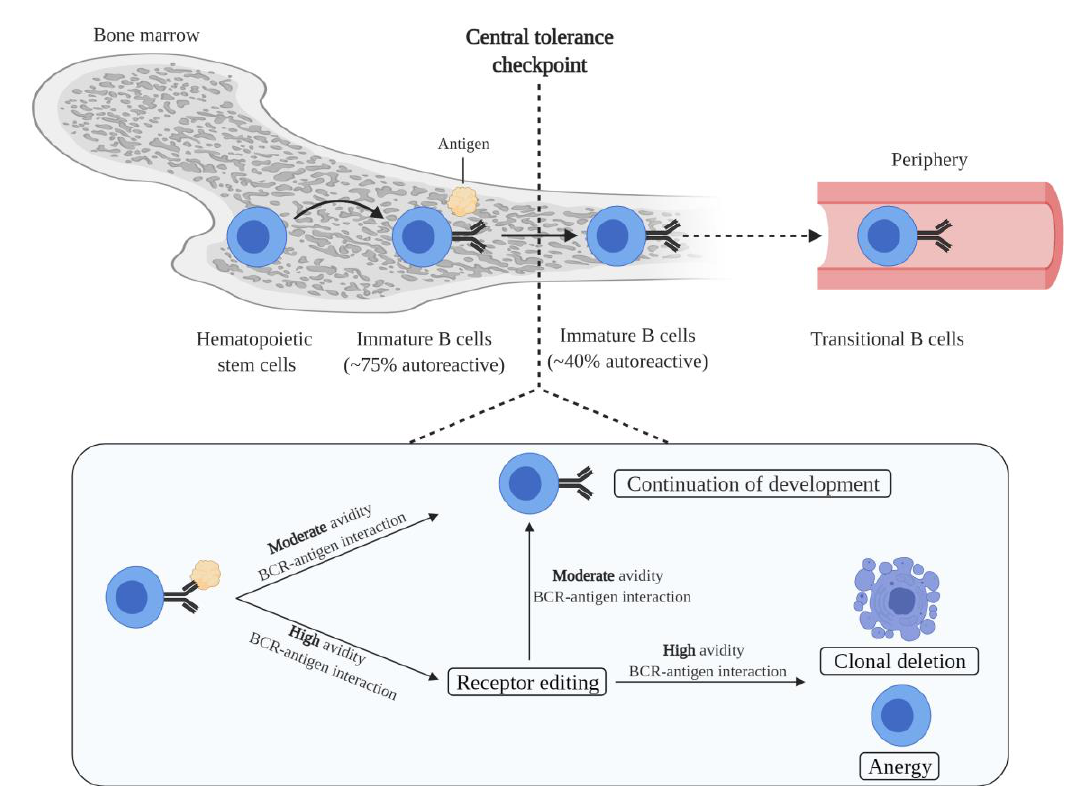
Figure 1. Elimination of autoreactive B cells by central tolerance mechanisms. The development of immature B cells from hematopoietic stem cells is accompanied by the generation of autoreactivity as the result of random variable (V), diversity (D), and joining (J) recombination. In the bone marrow, a significant proportion of autoreactive immature B cells is reduced at the central tolerance checkpoint. Central tolerance mechanisms include clonal deletion, anergy, and receptor editing. Central tolerance mechanisms are induced dependent on the binding strength between the BCR of immature B cells and self-antigens present in the bone marrow. Immature B cells that have escaped central tolerance mechanisms migrate into the periphery as transitional B cells. Figure was created with BioRender.